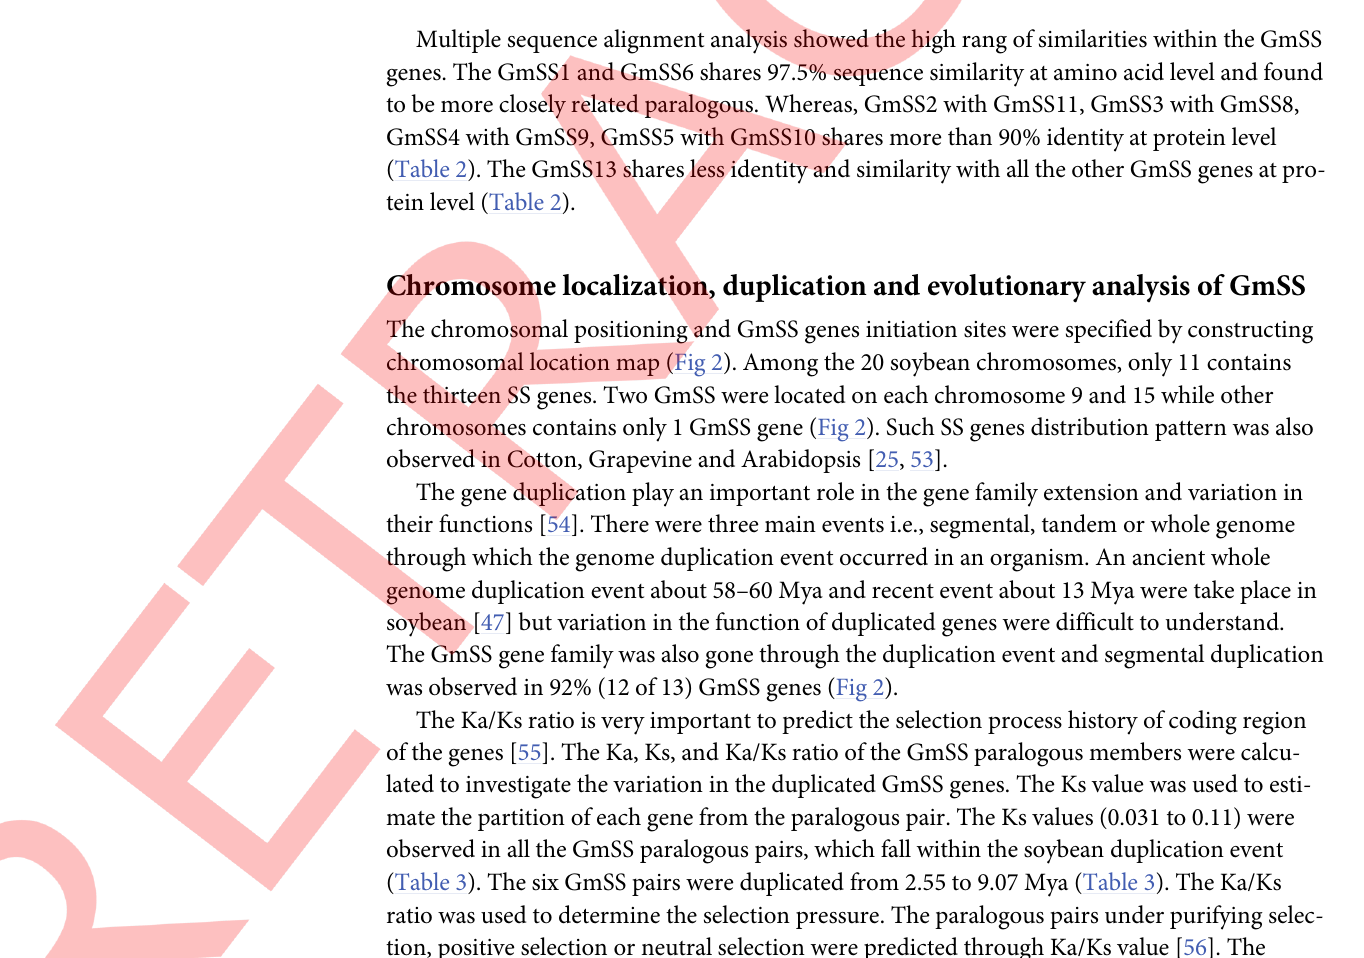
Multiple sequence alignment analysis showed the high rang of similarities within the GmSS